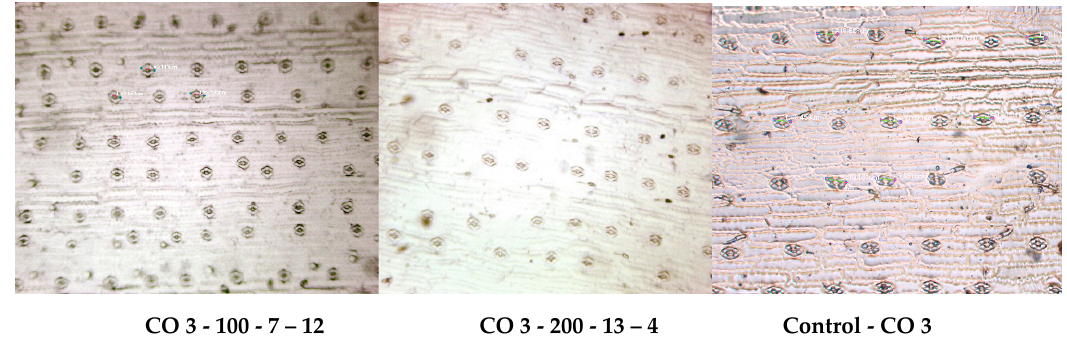
Figure 3. Stomatal distribution on the leaf epidermis of the identified extreme mutants along with control for photosynthetic e ffi cient trait.